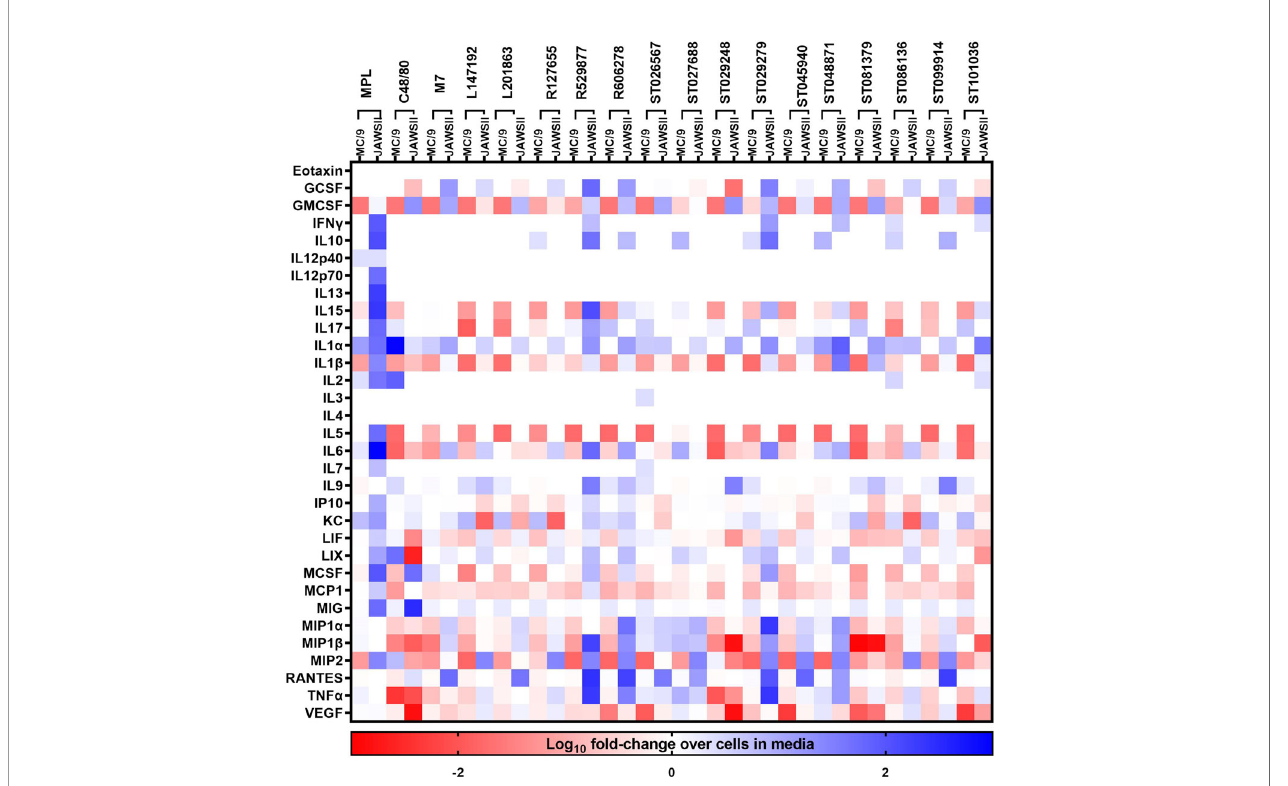
FIGURE 1 | Small molecule mast cell activators activate mouse innate immune cells. Mouse MC/9 mast cells or JAWSII dendritic cells were incubated in the presence of the small molecule mast cell activators (100 m M) or positive control vaccine adjuvants MPL, C48/80, or M7 for 24 hours. Cell supernatants were analyzed for cytokine production using a mouse 32-plex multiplex assay. Cytokine production was calculated as a fold-increase compared to cells cultured in media without additional stimuli. Data represents the log10 of the fold-increase in cytokine